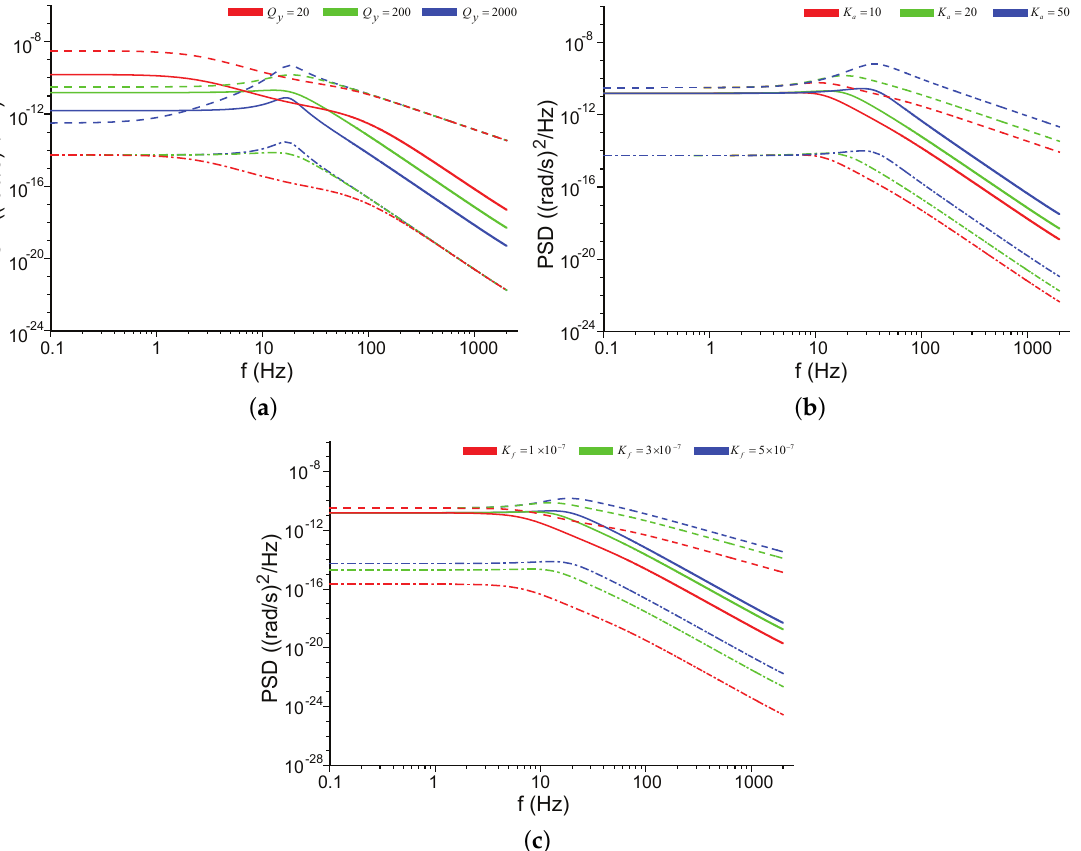
Figure 13. The PSD of the NER for different parameters in force-rebalance mode-matched gyroscopes. Solid lines for the mechanical NER. Dashed lines for the pickoff electrical NER. Dot-dashed lines for the feedback electrical NER. ( a ) Comparisons between different Q y ; ( b ) Comparisons between different gains of the signal conditioning circuit; ( c ) Comparisons between different gains of the feedback forcer.